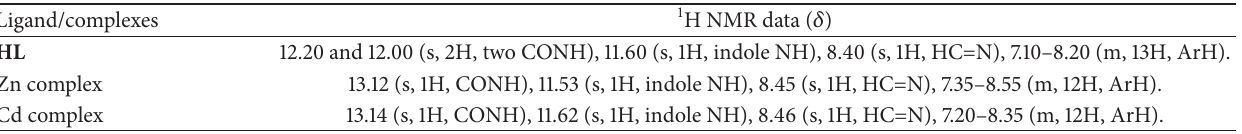
Table 3: The 1 H NMR data of ligand HL and its Zn(II) and Cd(II) complexes.